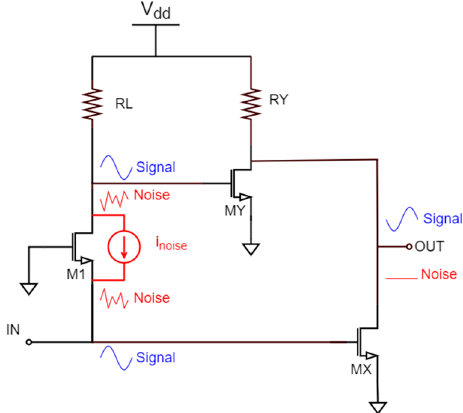
Figure 3. Common-gate amplifier with noise canceling.